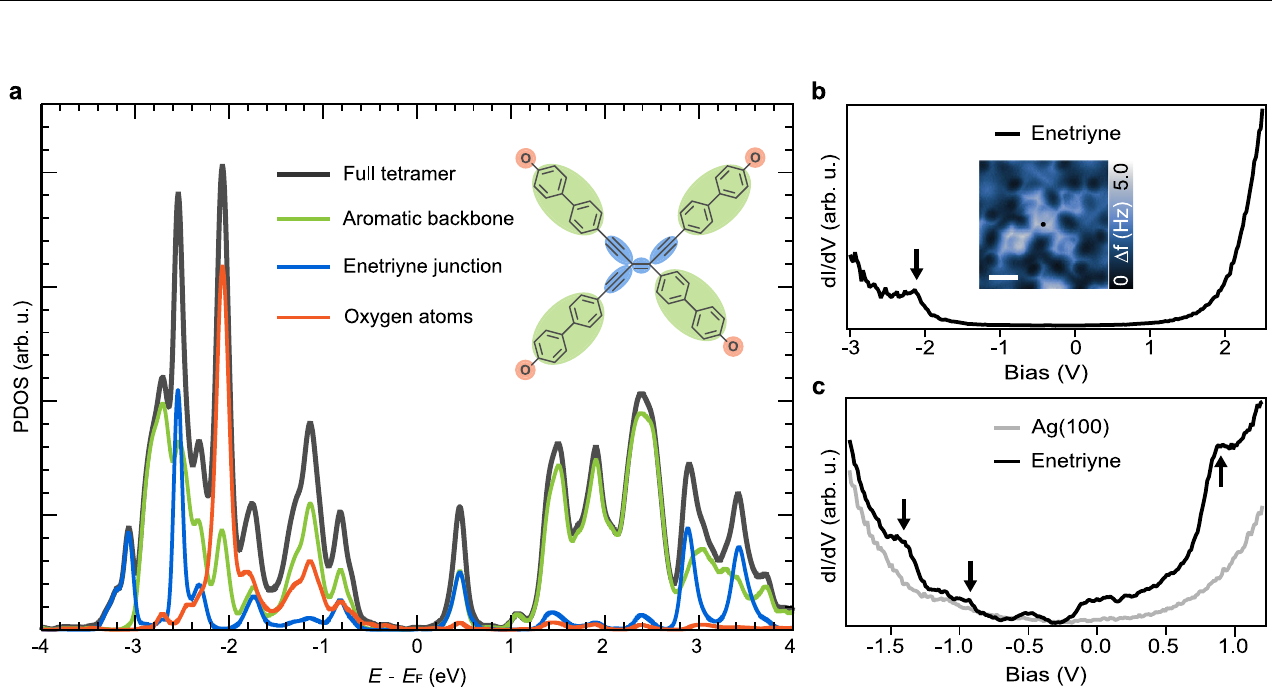
Fig. 7 | Electronic structure of the enetriyne tetramer products. a Theoretical PDOS calculated for an enetriyne tetramer adsorbed on a Ag(100) surface. The black, green, blue, and orange solid lines represent the DOS projected on the full tetramer, aromatic backbone, enetriyne junction, and oxygen atoms, respectively. b Differential conductance dI/dV spectrum ( − 3V~+2.5V) taken at the center of a